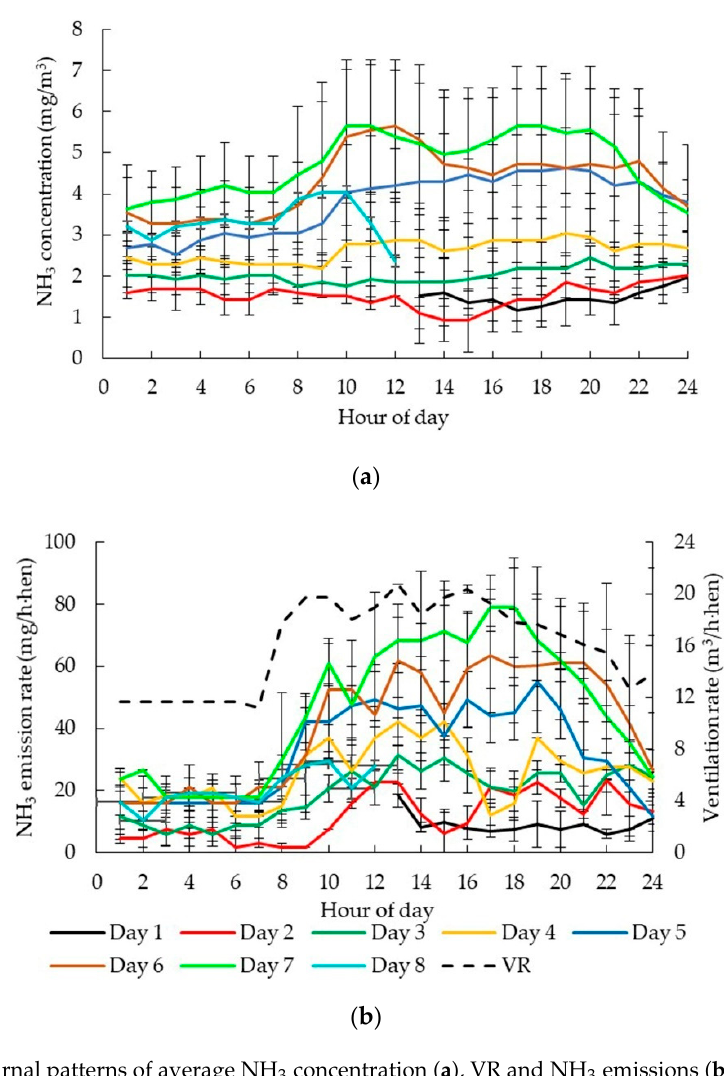
Figure 4. Diurnal patterns of average NH 3 concentration ( a ), VR and NH 3 emissions ( b ) in NM under different manure accumulated time. (Day 1 means the day of manure removal; Day 2 to Day 8 means the manure accumulated for 2 days to 8 days.). Appl. Sci. 2020 , 10 , x FOR PEER REVIEW